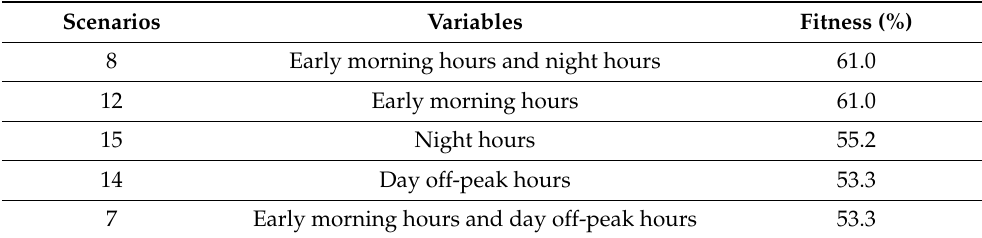
Table 6. Result of fitness